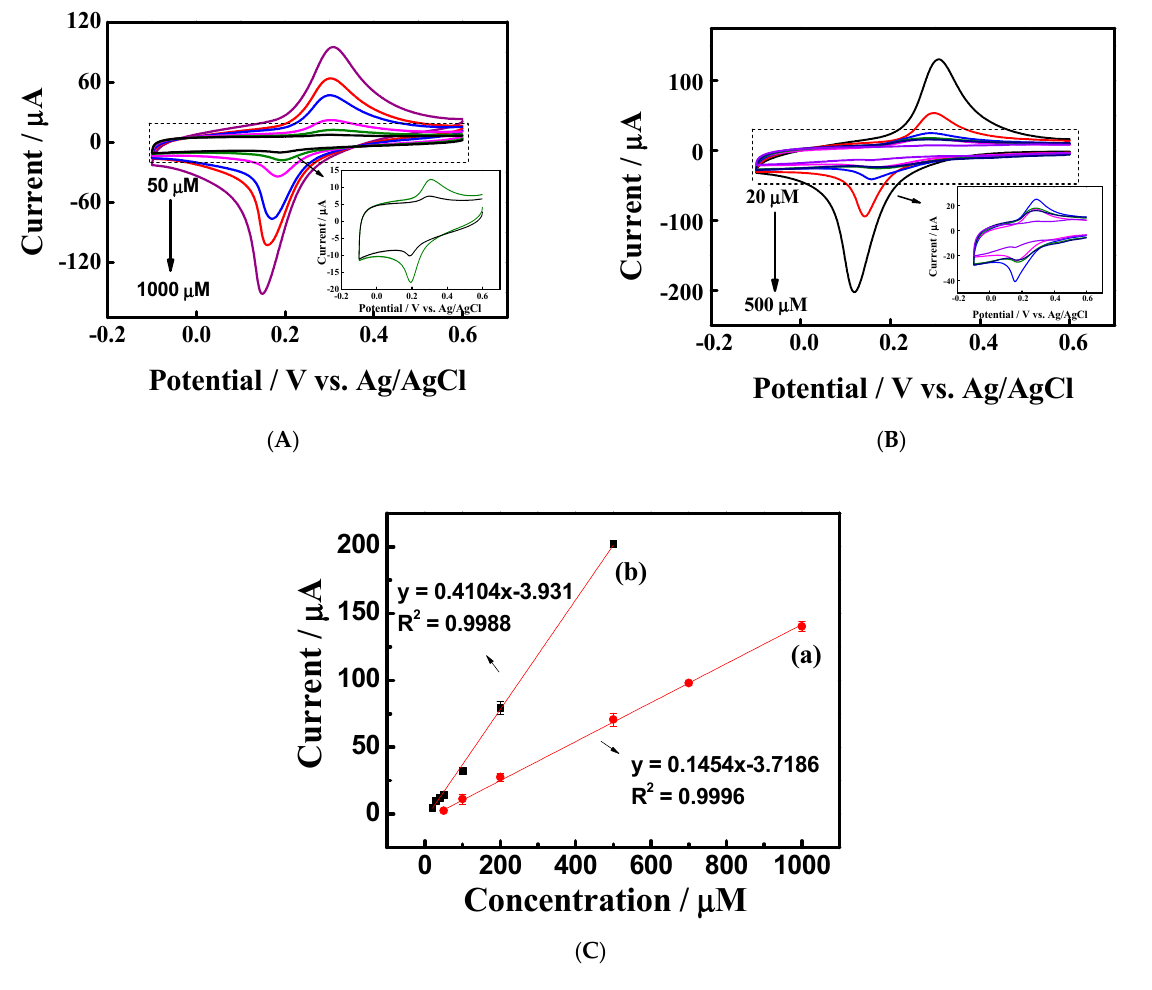
Figure 8. Cyclic voltammograms of SPCE/nano − Fe 3 O 4 /PBNC in 0.1 M KCl at ( A ) room temperature, and ( B ) 70 °C. Scan rate = 0.1 Vs − 1 . The electrodes were obtained using the same processes as shown in Figure 1A, except various concentrations of glyphosate were employed. ( C ) Calibration plot of cathodic peak current (converted cathodic currents to positive values) vs. glyphosate concentration. (a) room temperature, and (b) at 70 °C.